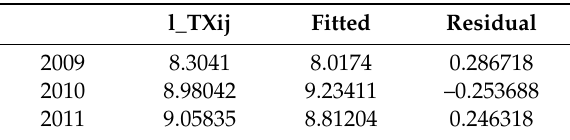
Table 9. Standard error of residuals. Model estimation range: 2009–2018; standard error of residuals